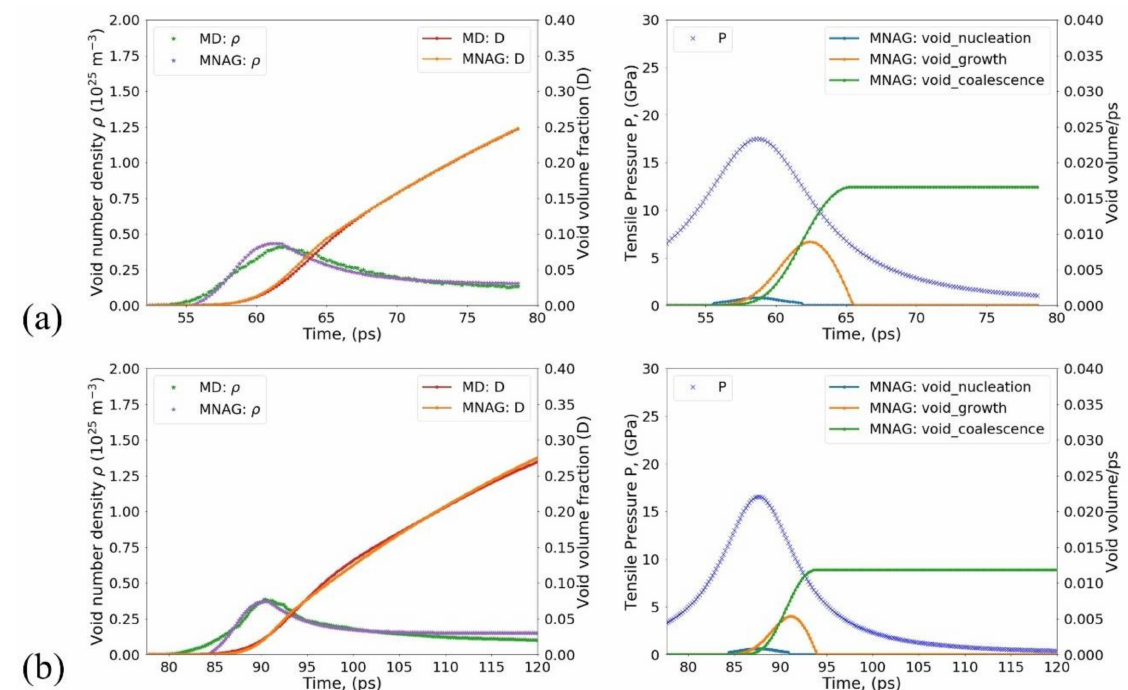
Figure 7. The MNAG model fitted to (001) single-crystal Ta with cell dimensions of: ( a ) 63 × 63 × 225 nm, ( b ) 95 × 95 × 338 nm. The left-hand panels show the evolution of the void number density and damage based on the MD and MNAG model, and the right-hand panels show the evolution of stress ( σ m ) and the contribution from void nucleation, growth and coalescence term over time based on MNAG